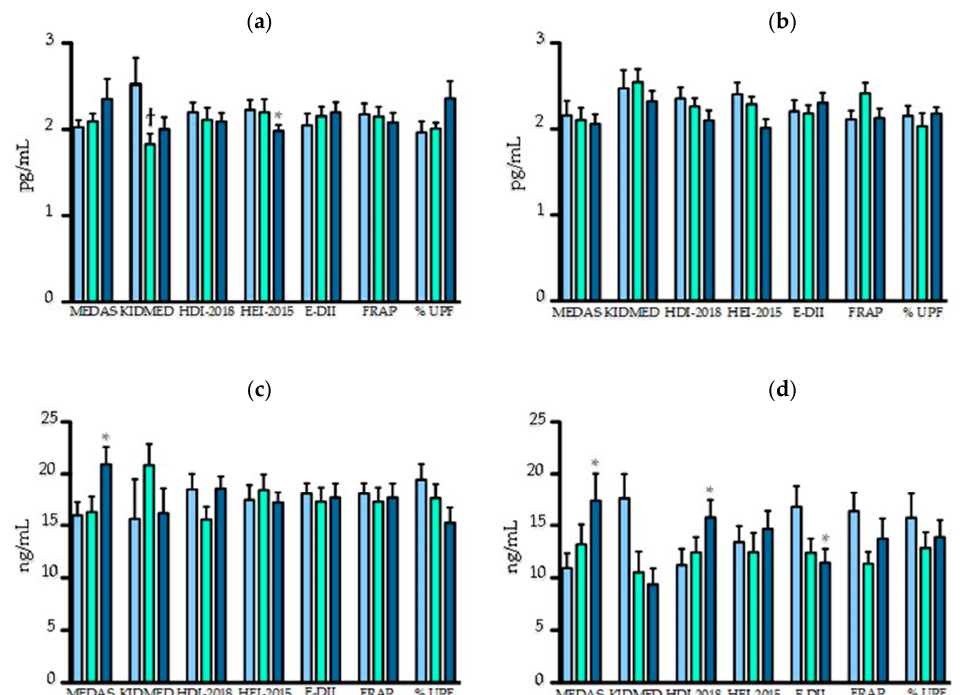
Figure 2. Inflammatory biomarker levels ( y axis) according to nutritional scores ( x axis). ( a ) TNF- α (pg / mL) in non-obese; ( b ) TNF- α in obese; ( c ) adiponectin (ng / mL) in non-obese; ( d ) adiponectin level in obese; * p < 0.05 tertile 3 vs. 1; † p < 0.05 tertile 2 vs. 1. MEDAS, Mediterranean Diet Adherence